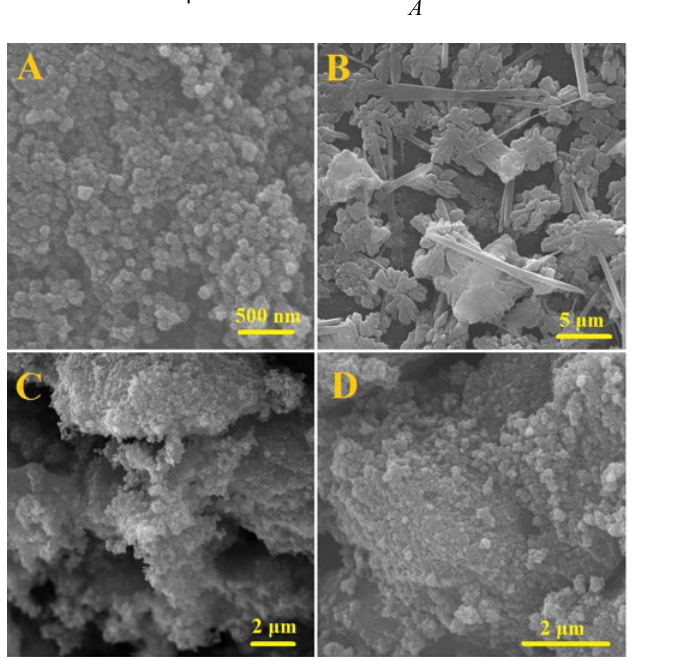
Fig. 1. SEM images of (A) Fe calcined at 500 ºC and (D) Fe